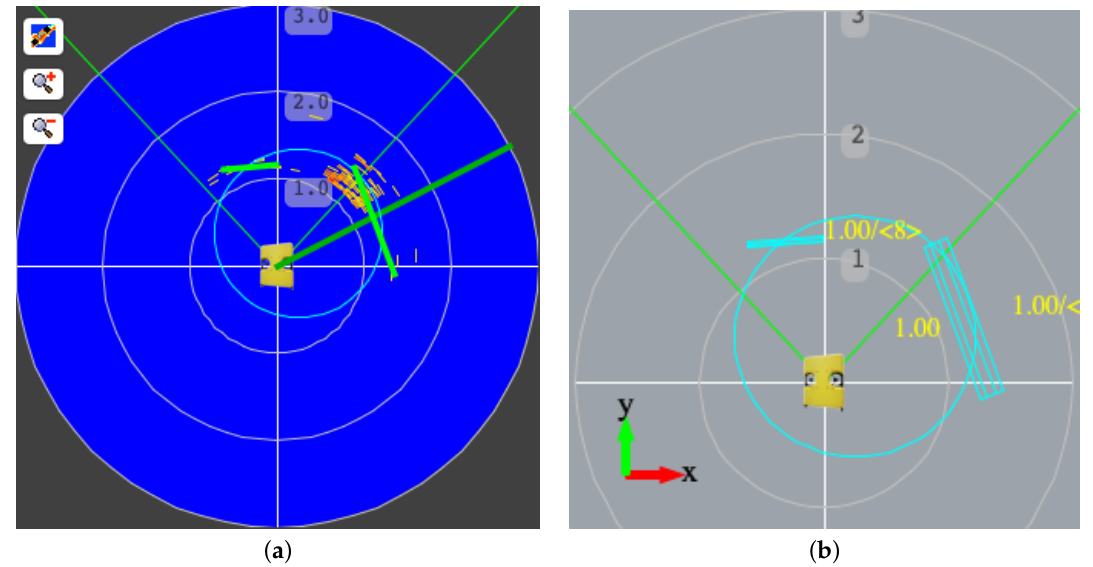
Figure 9. ( a ) Local buffer of sonar scanner data with line segment fitting and ( b ) fuzzy segment representation around the underwater